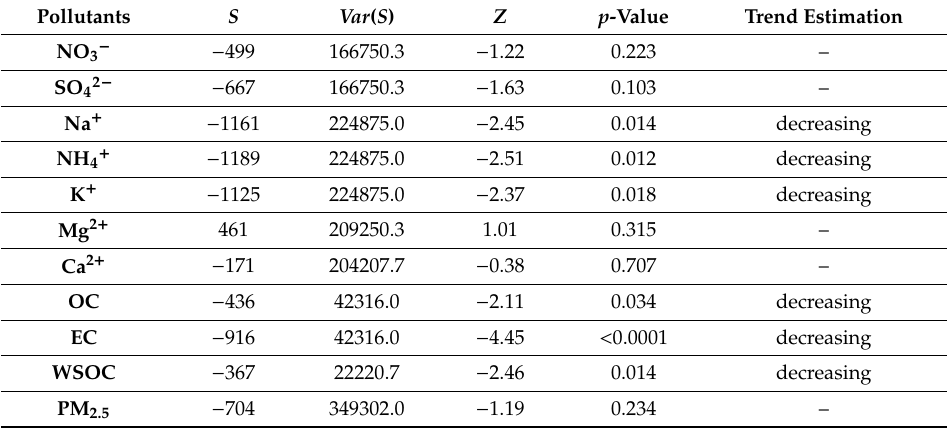
Table 4. Results of Mann-Kendall trend test on PM 2.5 and its